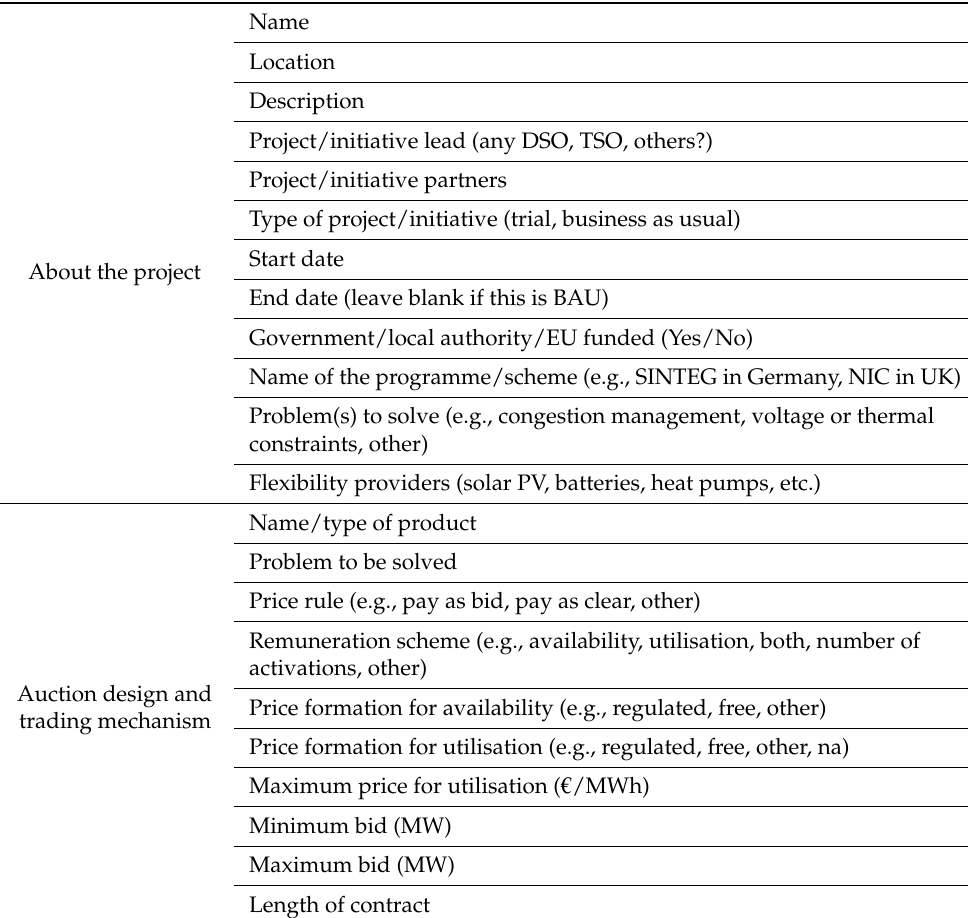
Table A1. Use Case